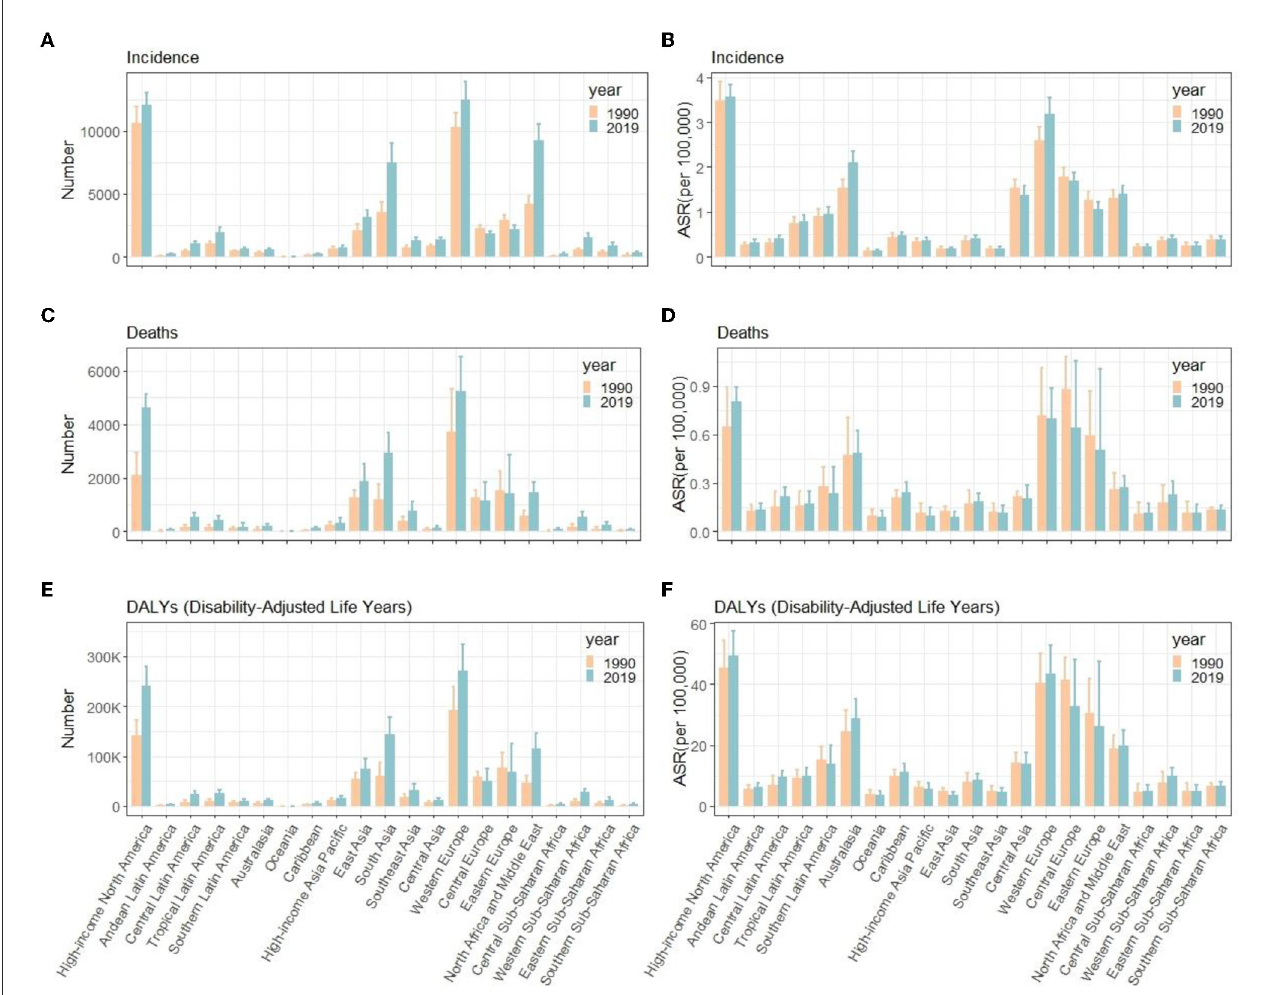
FIGURE5 Number and ASR of incidence (A, B) , deaths (C, D) , and DALYs (E, F) of multiple sclerosis in different GBD countries, 1990 and 2019. ASR, age- standardized rates; DALYs, disability-adjusted life years; GBD, global burden of diseases, injuries, and risk factors study.